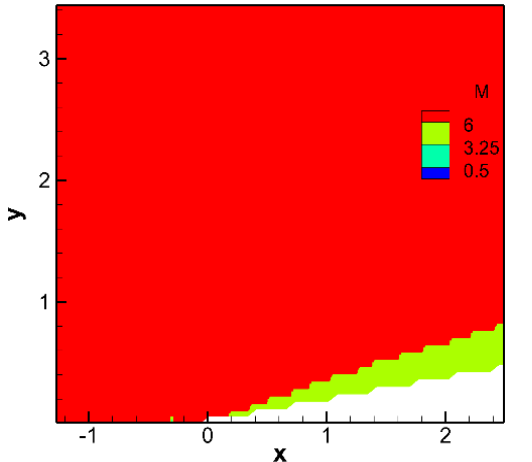
Figure 15. Mach number contour using 1-D DPS on Figure 16. Mach number plot at y = 0.5 location